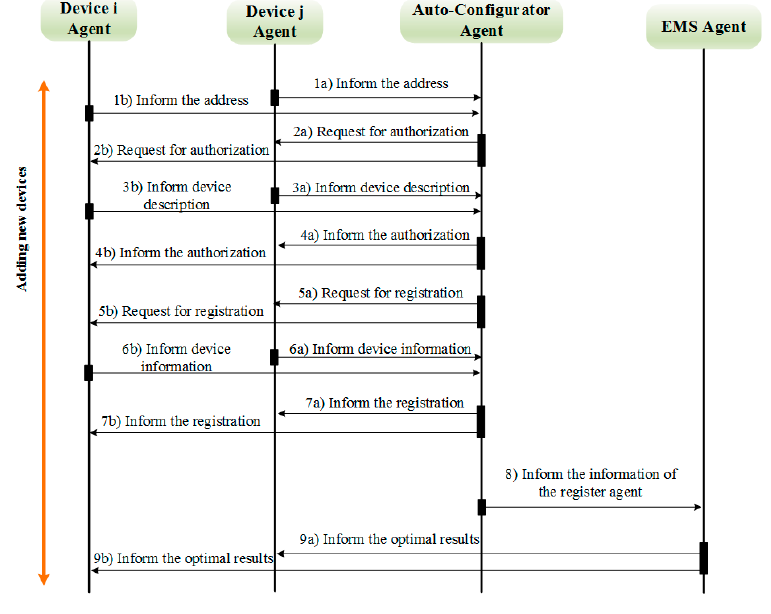
Figure 5. Sniffer diagram for adding new devices.